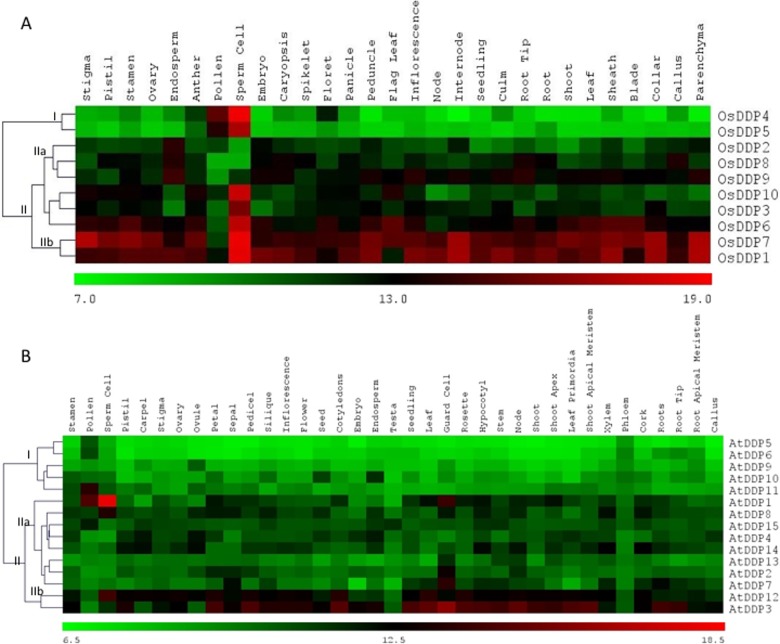
Microarray-based expression pattern of DDP genes in different tissues/organs.Expression profile of DDP genes generated from microarray data indifferent tissues/organs of (A) rice and (B) Arabidopsis. The heatmaps represent hierarchical clustering (using Euclidean distance metric) of average log signal values of DDP genes and were generated using MeV software package. The color bar below the heat maps represent relative expression values with green color representing the lowest expression while as, red the highest expression level. Cluster-grouping represented by Roman numbers followed by letters as discussed in the text.